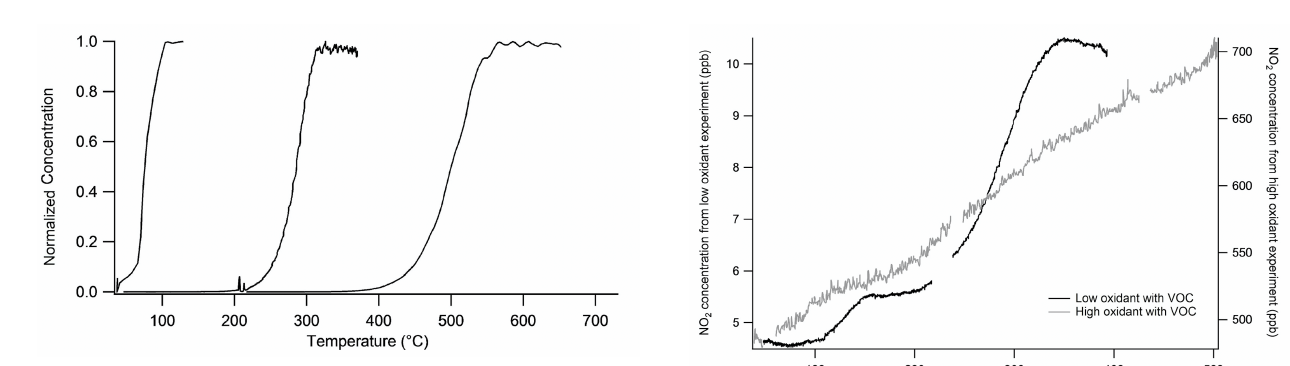
Figure 4. Temperature ramps on all thermally dissociated species, in order from left to right: chamber-generated PNs, isobutyl nitrate, and HNO 3 from pure samples diluted in zero air. The absolute con- centrations of PNs, ANs, and HNO 3 were 230, 200, and 3000ppb, respectively.